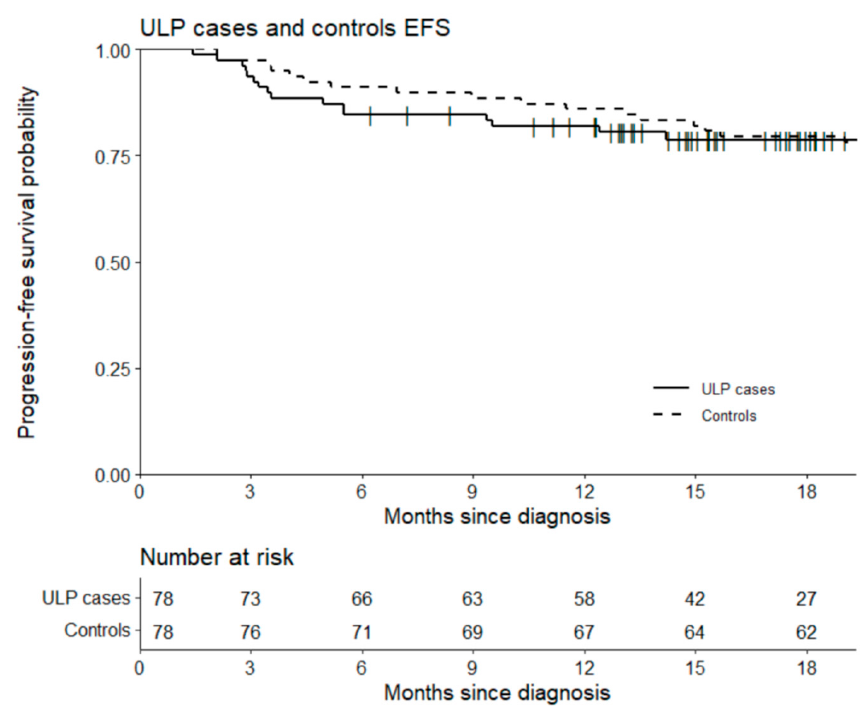
Figure 5. Progression-free survival of cases (including in ULP) and control groups.